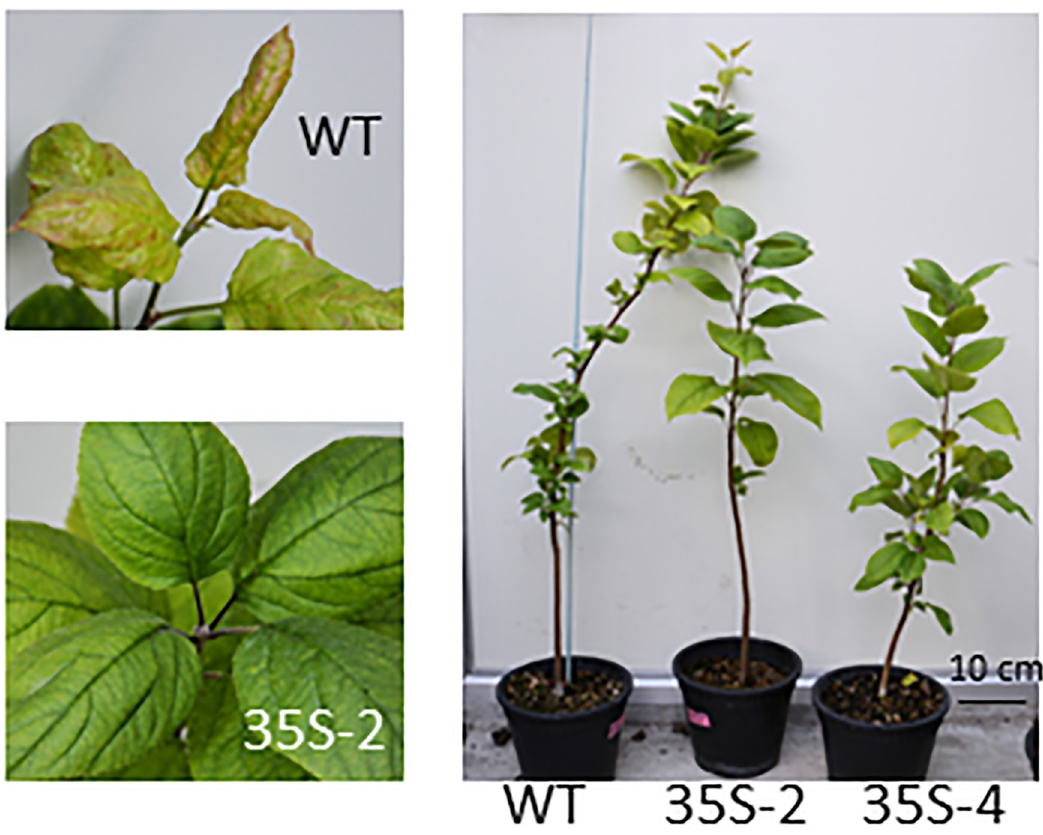
Fig 2. Early bud set observed in 4-year-old 35S : PmDAM6 apple plants. Photographs of 4-year-old plants taken on 24 July 2014. Early bud set was observed in 35S-2 plants (left).